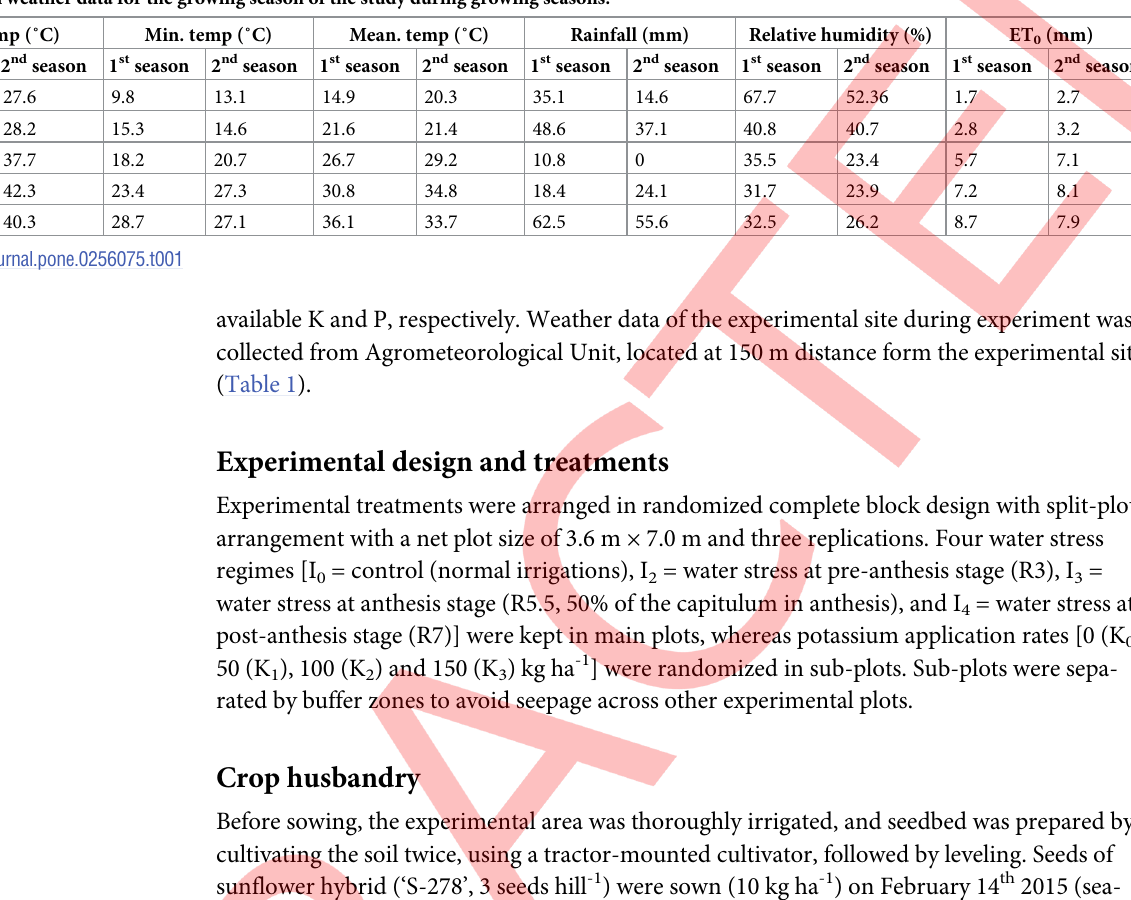
Table 1. Monthly mean weather data for the growing season of the study during growing seasons. Max temp (˚C) Min. temp